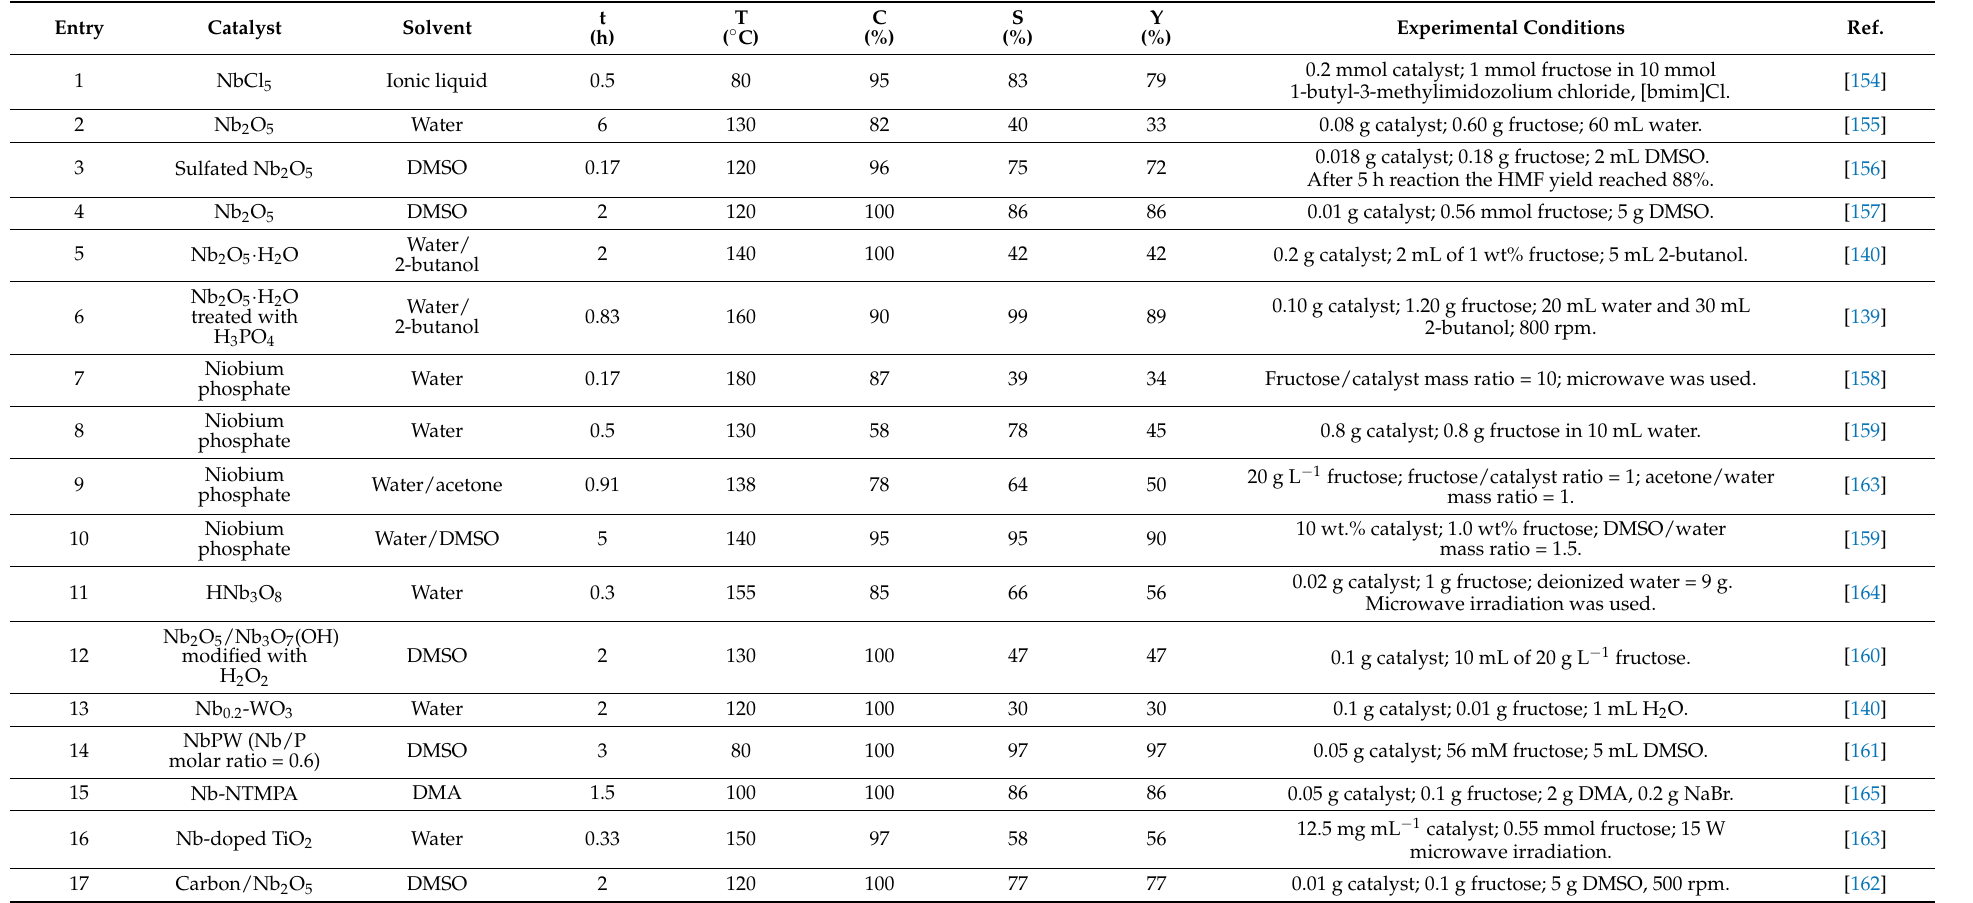
Table 5. Performance of niobium-based catalysts for dehydration of fructose into HMF—from 2010 to